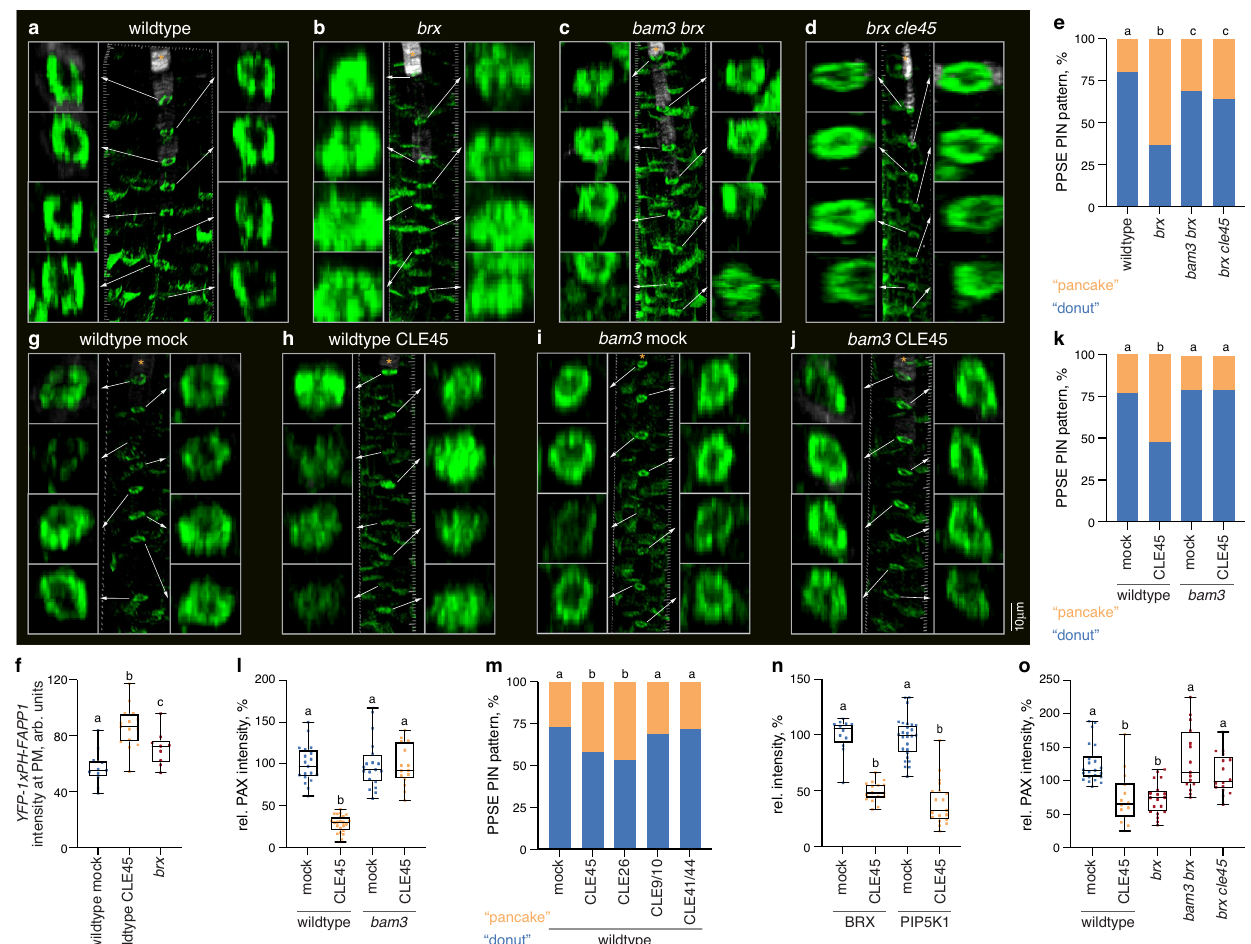
Fig.3|CLE45-BAM3signalingimpairsauxinef fl uxcontrolindevelopingPPSEs. a – d Confocal microscopy images of PIN1 localization (anti-PIN1 immunostaining, green fl uorescence) in developing PPSE cell fi les (calco fl uor staining, gray fl uores- cence; asterisks) of 5-day-old seedlings of indicated genotypes, 3D reconstruction. Centerpanels:overview;Sidepanels:magni fi edimagesofindividualPPSErootward membranes, with positions indicated by arrows. e Scoring of subcellular PIN pat- terning in developing PPSEs of 5-day-old seedlings exempli fi ed in ( a – d ). n =17 – 23 roots, 141 – 249 PPSEs per genotype; Statistically signi fi cant differences (lower case letters) were determinedby Fisher ’ s exact test, p <0.001. f Relativeintensity of